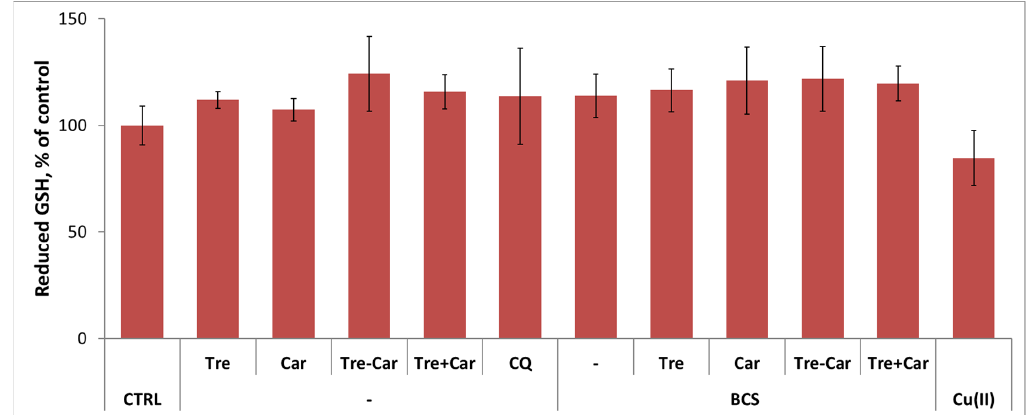
Figure 10. The ionophore ligands do not perturb GSH redox state. PC12 cells were treated with 5 mM Tre, Car, Tre-Car and Tre + Car mixture or 10 µM CQ for 16 h in the presence or in the absence of 50 µM BCS or 50 µM copper (as positive control) in RPMI-1640 complete medium without FBS.